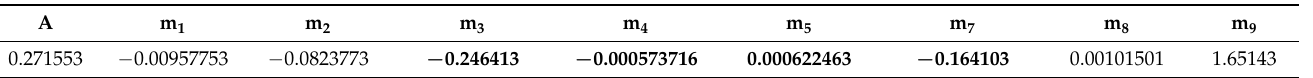
Table 1. Coefficients of Equation (4) used to determine σ p values of the 5019 aluminium alloy (Variant 1)